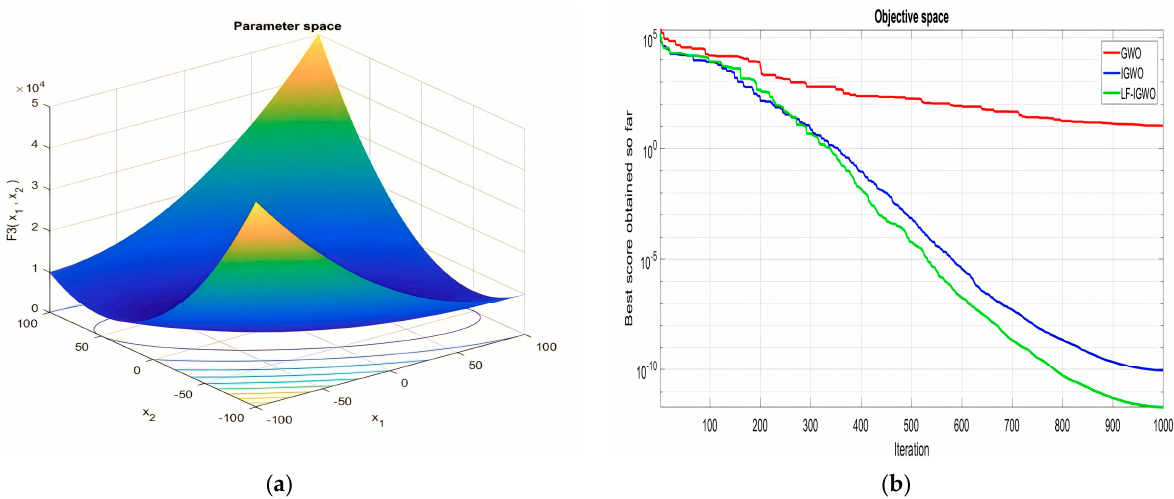
Figure 5. ( a ) Search space for unimodel function F03 ( b ) Comparison of convergence curve for F03.